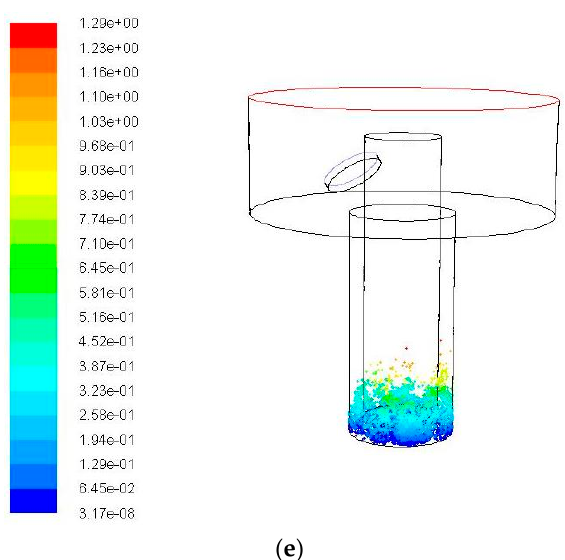
Figure 6. The debris movement with time when ultrasonic frequency is 20 kHz, amplitude is 5 μ m. ( a ) Initial debris distribution; ( b ) Debris distribution at 0.01 s; ( c ) Debris distribution at 0.02 s; ( d ) Debris distribution at 0.03 s; and, ( e ) Debris distribution at 0.04 s.